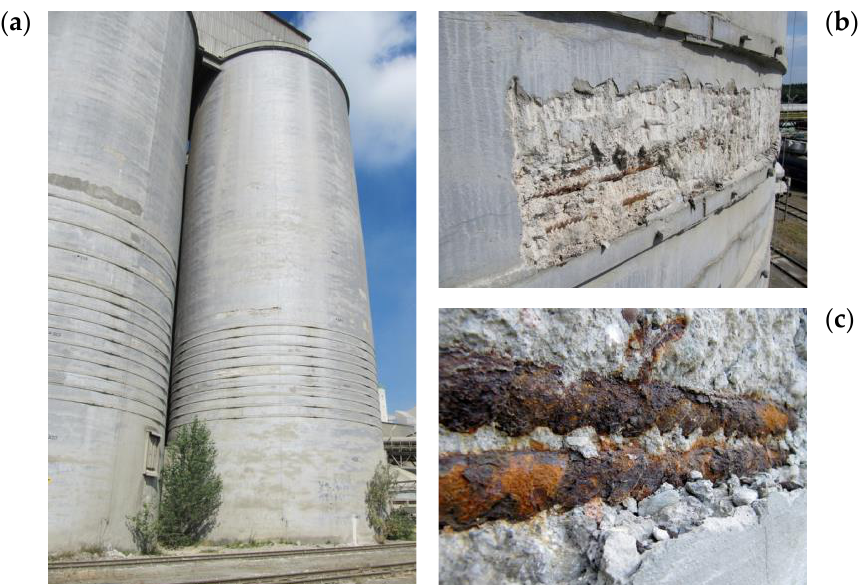
Figure 9. The tested structure of cylindrical silos for cement: ( a ) the outer shell surface of the silos; ( b ) corroded fragment of the perimeter wall with locally uncovered corroded reinforcement; and ( c ) very corroded steel rebars without concrete cover, directly exposed to atmospheric